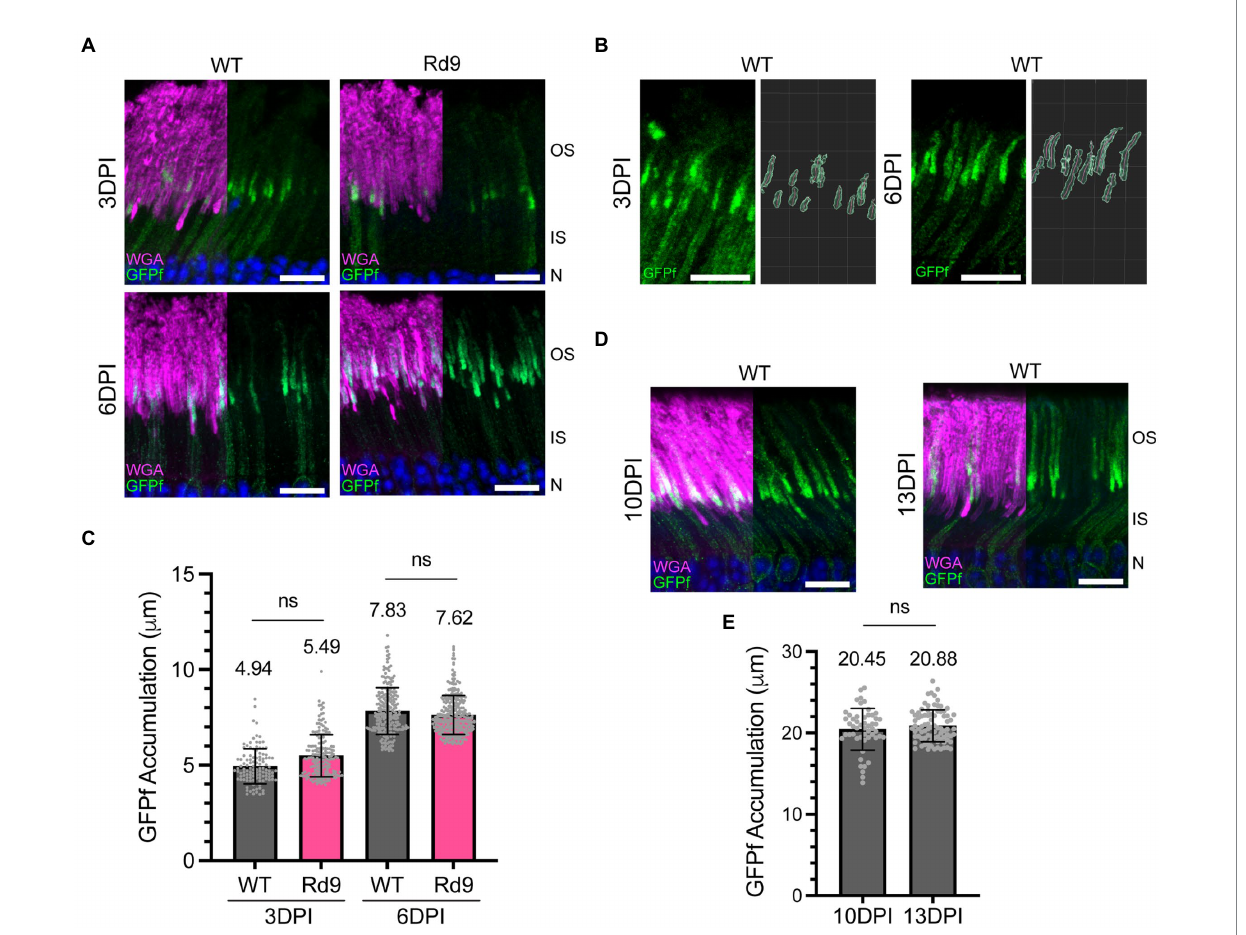
FIGURE 4 Investigating whether the Nrl:CreERT2/GFPf model can be used to measure rates of outer segment renewal. (A) Retinal cross-sections from WT and Rd9 mice on the Nrl:CreERT2/GFPf background at 3 and 6 DPI stained with anti-GFP antibody and WGA. Nuclei are counterstained with Hoechst. Scale bars, 10 μ m. (B) Representative images showing the analysis used to measure the length of GFPf accumulation in outer segments. (C) Bar graph plotting stratified measurements of GFPf accumulation in outer segments. Mean values are displayed above the bars. Error bars represent S.D. Linear mixed modeling: 3 DPI ns p = 0.531 and 6 DPI ns p = 0.896. (D) Retinal cross-sections from WT mice on the Nrl:CreERT2/GFPf background at 10 and 13 DPI stained with anti-GFP antibody and WGA. Nuclei are counterstained with Hoechst. Scale bars, 10 μ m. (E) Bar graph plotting stratified measurements of GFPf accumulation in outer segments. Mean values are displayed above the bars. Error bars represent S.D. Linear mixed modeling: ns p =